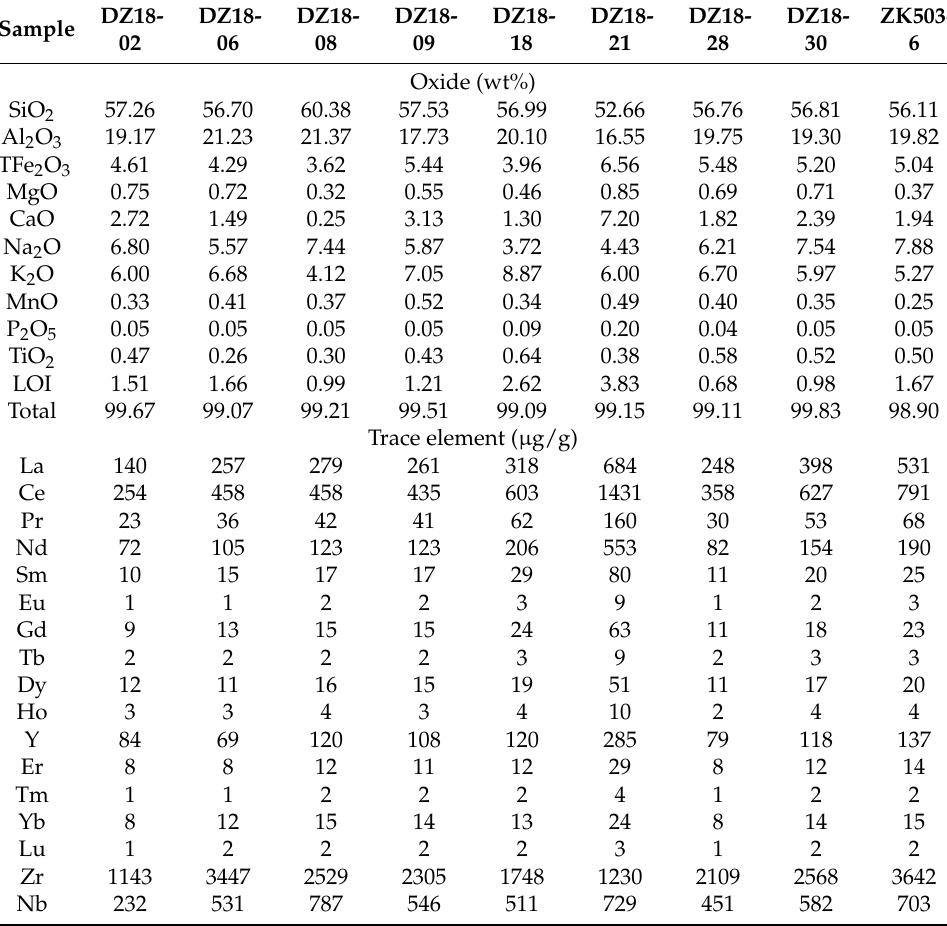
Table A2. Major element composition and Rare Earth Elements (REEs) + Zr and Nb composition of Shuangshan nepheline syenite. The major element and trace element were obtained by X-ray fluorescence (XRF) and ICP-MS, respectively, at the State Key Laboratory of Ore Deposit Geochemistry of the Chinese Academy of